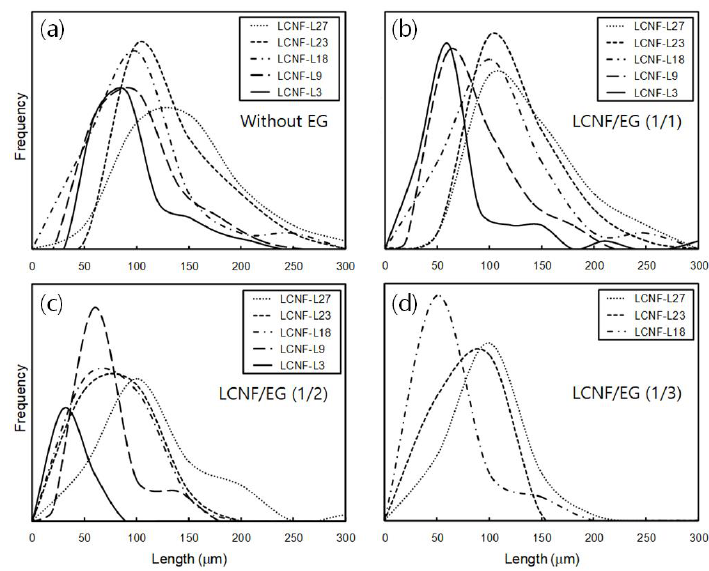
Figure 2. Diameter distribution of the insufficiently defibrillated products with different lignin contents after enzymatic treatment using different EG contents; ( a ) without EG, ( b ) LCNF/EG (1/1), ( c ) LCNF/EG (1/2), ( d ) LCNF/EG (1/3). Table 2. Average lengths and standard deviations of the insufficiently defibrillated products with different lignin contents after enzymatic treatment using different EG contents (units: μm).